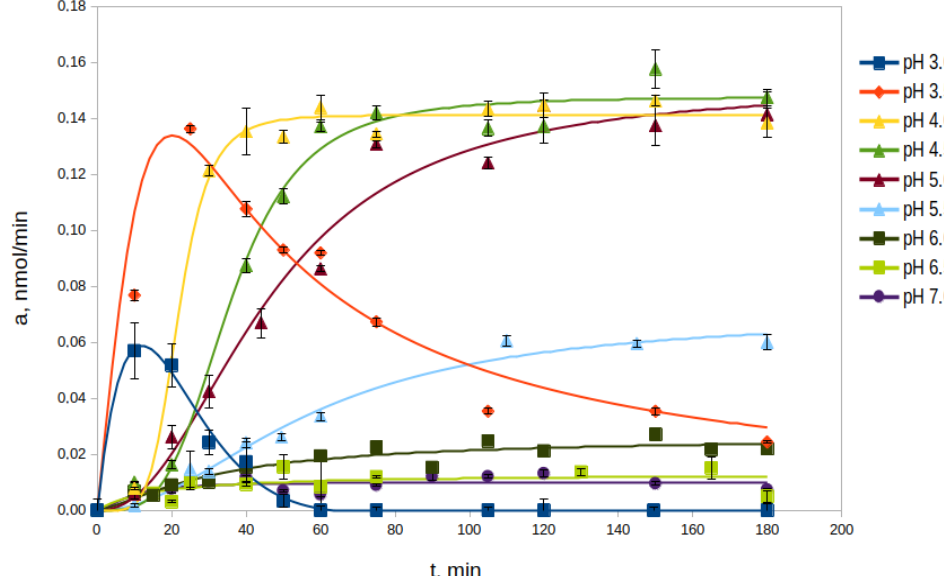
Figure 1. Effect of pH on the rate of rpTcCathL1 processing. The activity of the mature rTcCathL1 was measured with 0.5 mM Glp-Phe-Gln-pNA in 0.1 M universal buffer (UB), pH 5.6 in the presence of 6 mM cysteine and 1 mM ethylenediaminetetraacetic acid